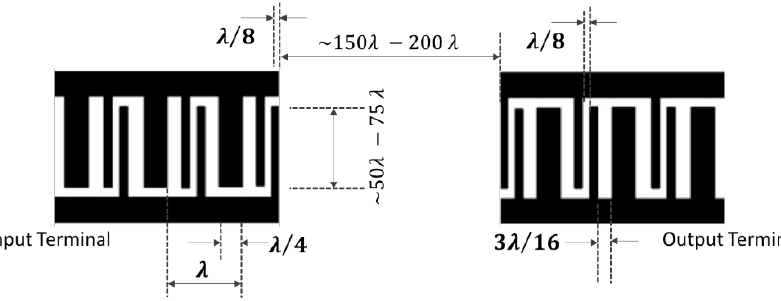
Figure 12. Schematic representation of the SPUDT electrode configuration [2].